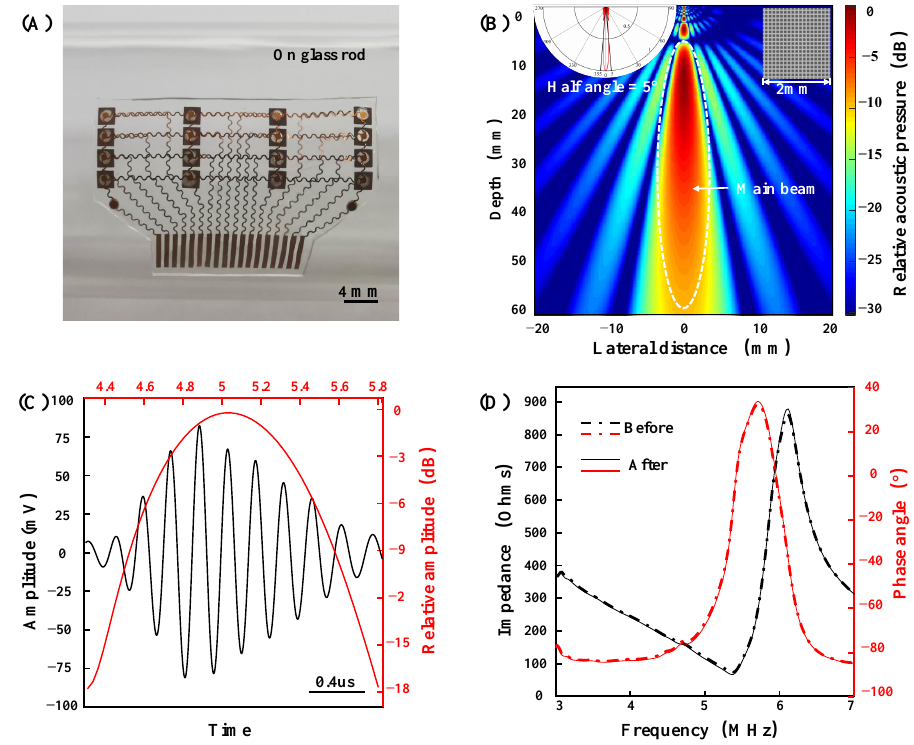
Figure 5. Device characterization. ( A ) Optical image of the device when bent around a curved glass rod. ( B ) Theoretical beam pattern of a single 1–3 composite piezoelectric transducer. ( C ) Time and frequency domain characterizations of the signal from a carotid arterial distal wall. ( D ) The impedance and phase angle of the device before and after 300 bending